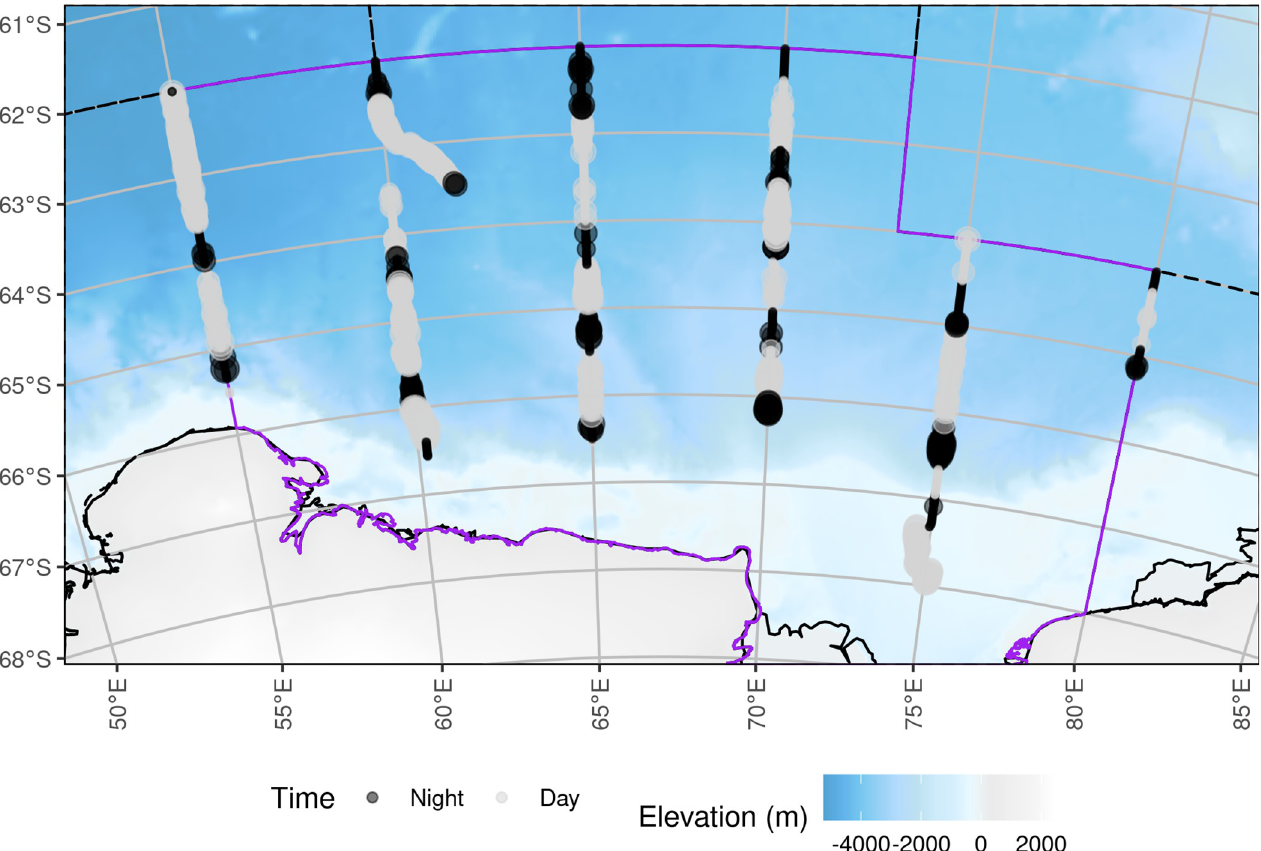
Fig 9. Day/night effort distribution of survey. Point area is proportional to krill areal biomass density. The background bathymetry grid is from The GEBCO_2014 Grid, version 20150318, www.gebco.net.